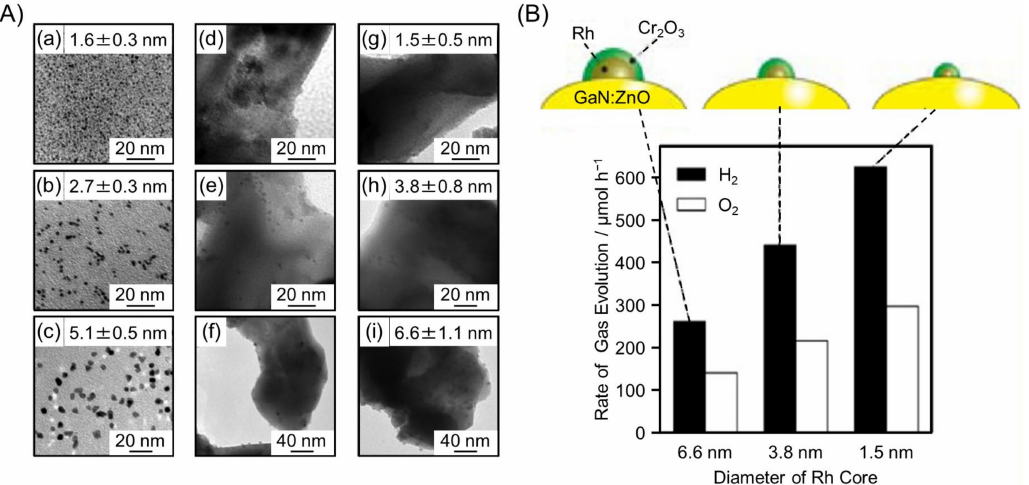
Figure 18. ( A ) TEM images of three types of Rh NPs: ( a – c ) as-synthesized, ( d – f ) adsorbed on GaN:ZnO, and ( g – i ) loaded on GaN:ZnO after calcination. ( B ) Initial rates of H 2 and O 2 evolution over GaN:ZnO loaded with different-sized Cr 2 O 3 /Rh (core–shell) NPs. Reaction conditions: catalyst, 0.15 g; H 2 SO 4 aq. (pH 4.5), 400 mL; light source, high-pressure Hg lamp (450 W) through NaNO 2 aq. filter to cut UV light; reaction vessel, Pyrex inner-irradiation type. Reproduced with permission from reference [218]. Copyright 2013 American Chemical